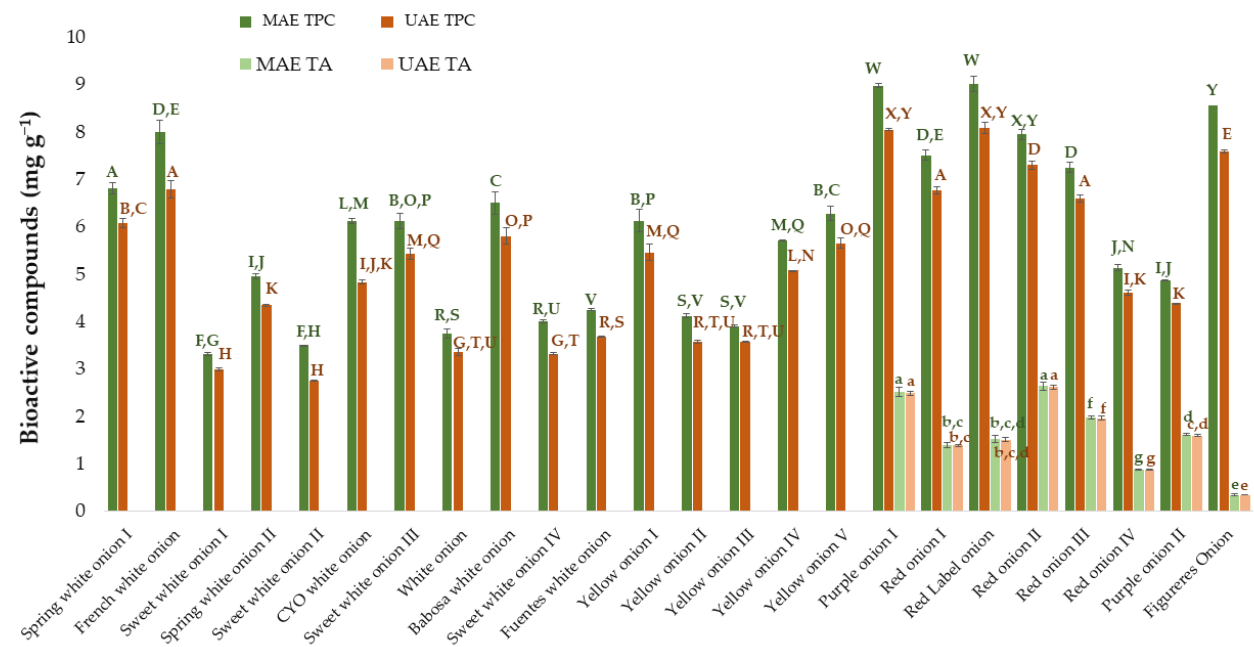
Figure 6. Amount of total phenolic compounds and total anthocyanins extracted by MAE and UAE from different onion varieties. MAE TPC: total phenolic compounds extracted by the optimized MAE method. MAE TA: total anthocyanins extracted by the optimized MAE method. UAE TPC: total phenolic compounds extracted by the optimized UAE method. UAE TA: total anthocyanins extracted by the optimized UAE method. The data in the graph are the mean of 3 replicates ± the standard deviation (expressed as error bars). Different letters mean statistically significant differences according to Tukey ’ s test at the 95% level of significance.